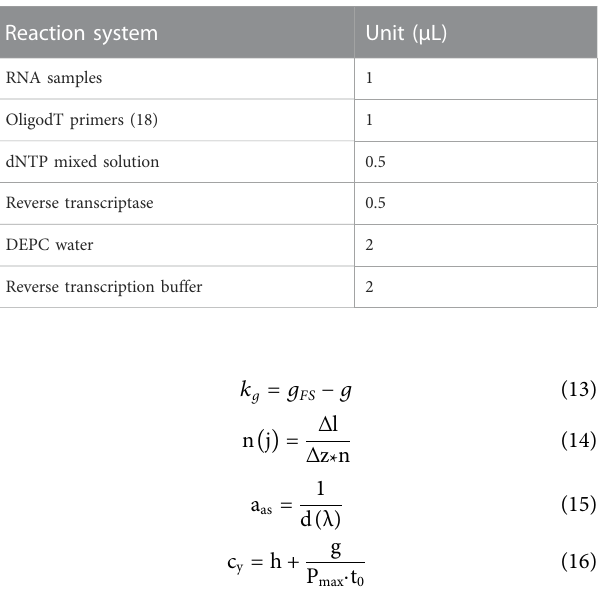
TABLE 1 Reverse transcription